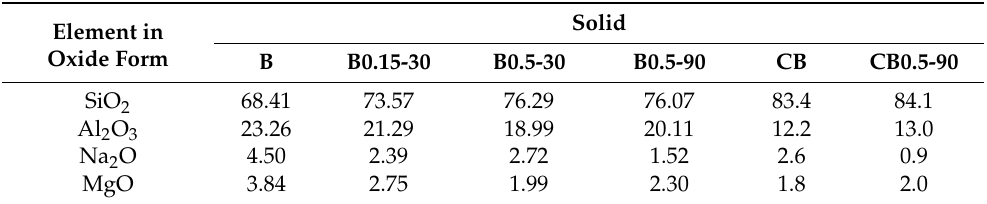
Table 2. Approximate composition of the